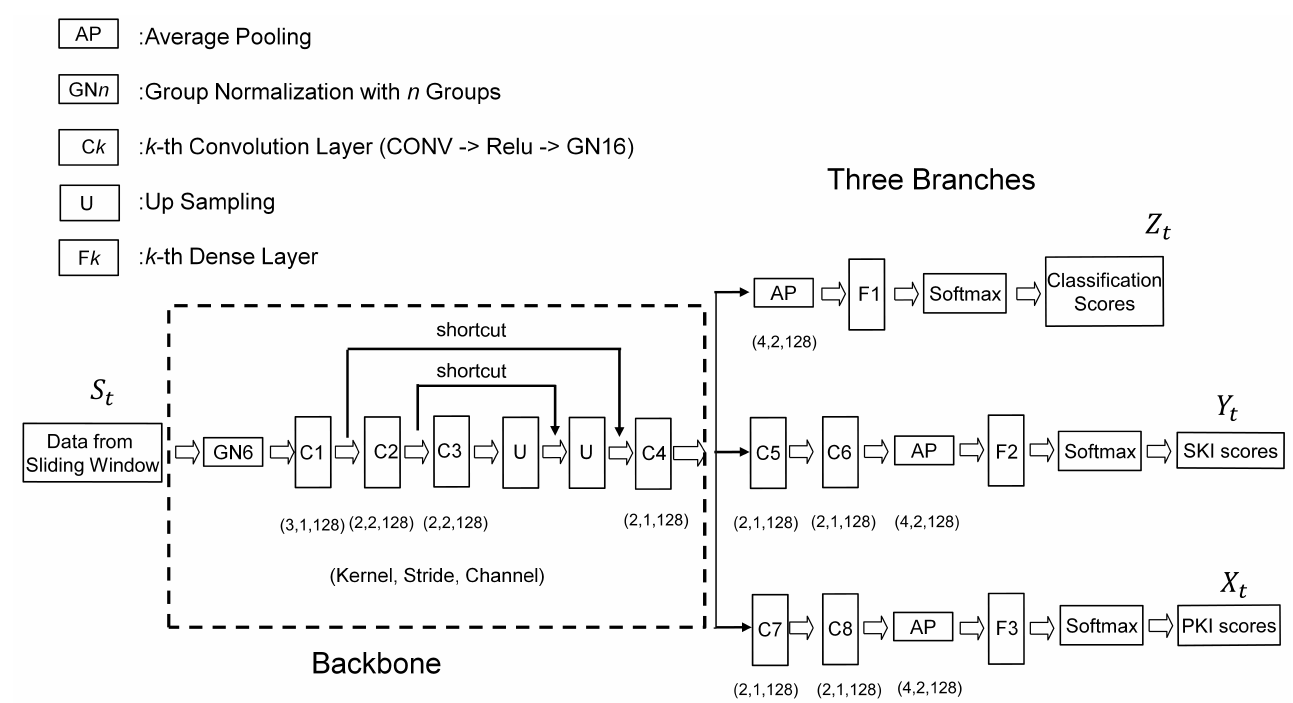
Figure 2. The proposed neural network model for gesture detection and classification. The model contains a backbone and three branches. The samples from a sliding window of a sequence S serve as input data. The model then produces PKI scores, SKI scores, and classification scores corresponding to the sliding